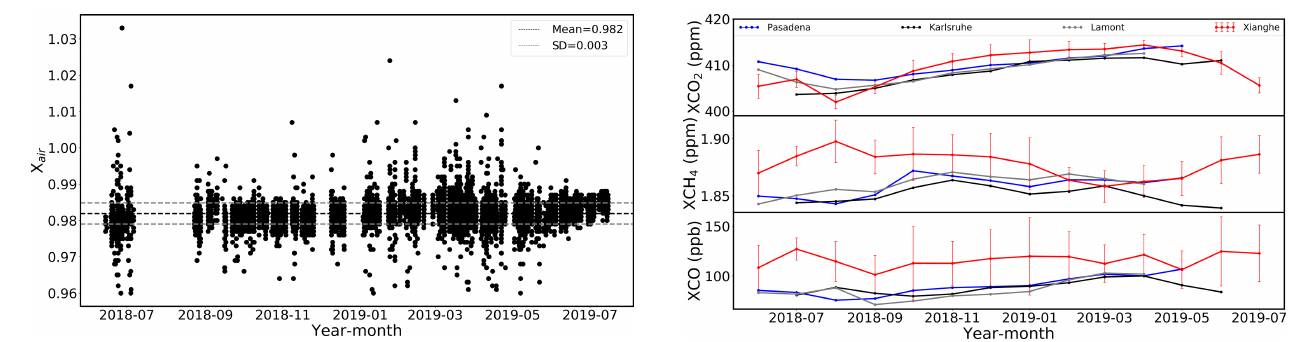
Figure 7. Time series of X air at Xianghe between 14 June 2018 and 19 July 2019.